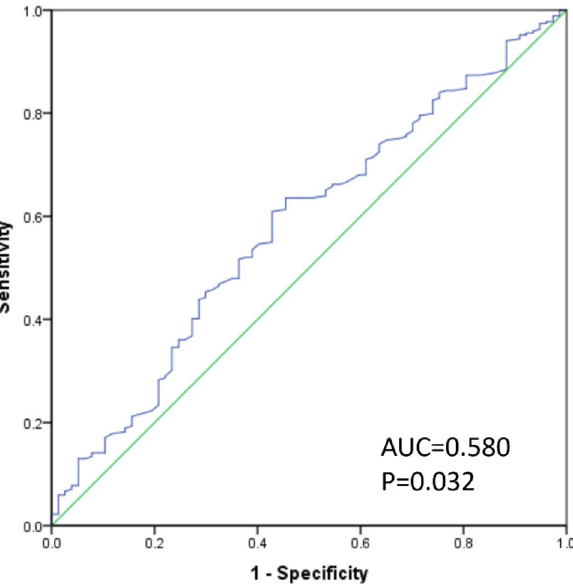
Figure 2. Receiver operating characteristic (ROC) and area under the curve (AUC) analyses pertaining to absolute neutrophil/lymphocyte ratio (NLR) at